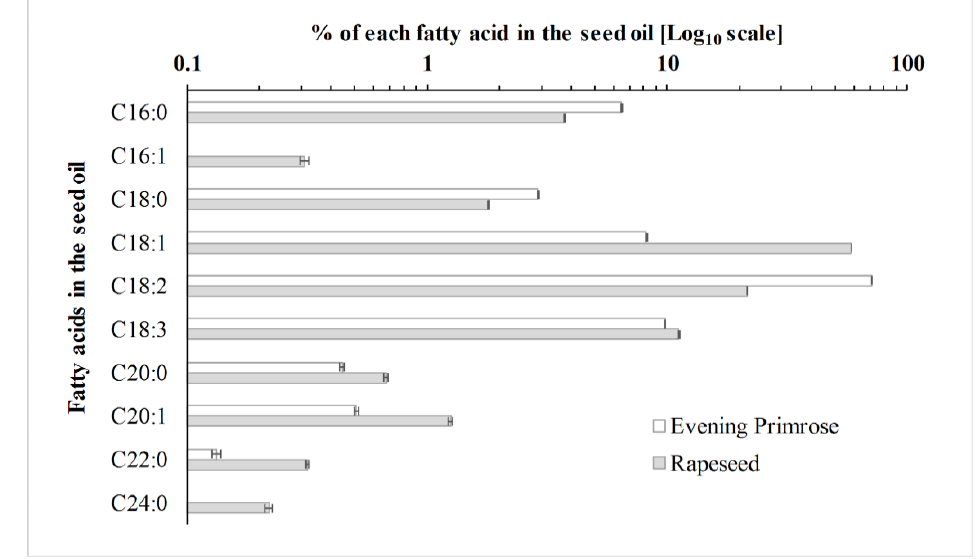
Figure 7. Concentration of each fatty acid in the seed oil of Oenothera biennis L. (Evening Primrose) and Brassica napus L cv. serw 1 L. local genotype (Rapeseed) grown in 2 growing seasons in a P and K deficient soil and fertilized with 142.9 kg N ha −1 , 171.4 kg K 2 O ha −1 , or 36.9 kg P 2 O 5 ha −1 . Data are means ± S.E. of the N, P, and K fertilization treatments. Species differed by each fatty acid (see Supplementary Materials Table S3). N = 48. Please note that error bars are standard error estimates of the LSmeans and not the computed standard error, which can be found in Supplementary Materials Table S2.